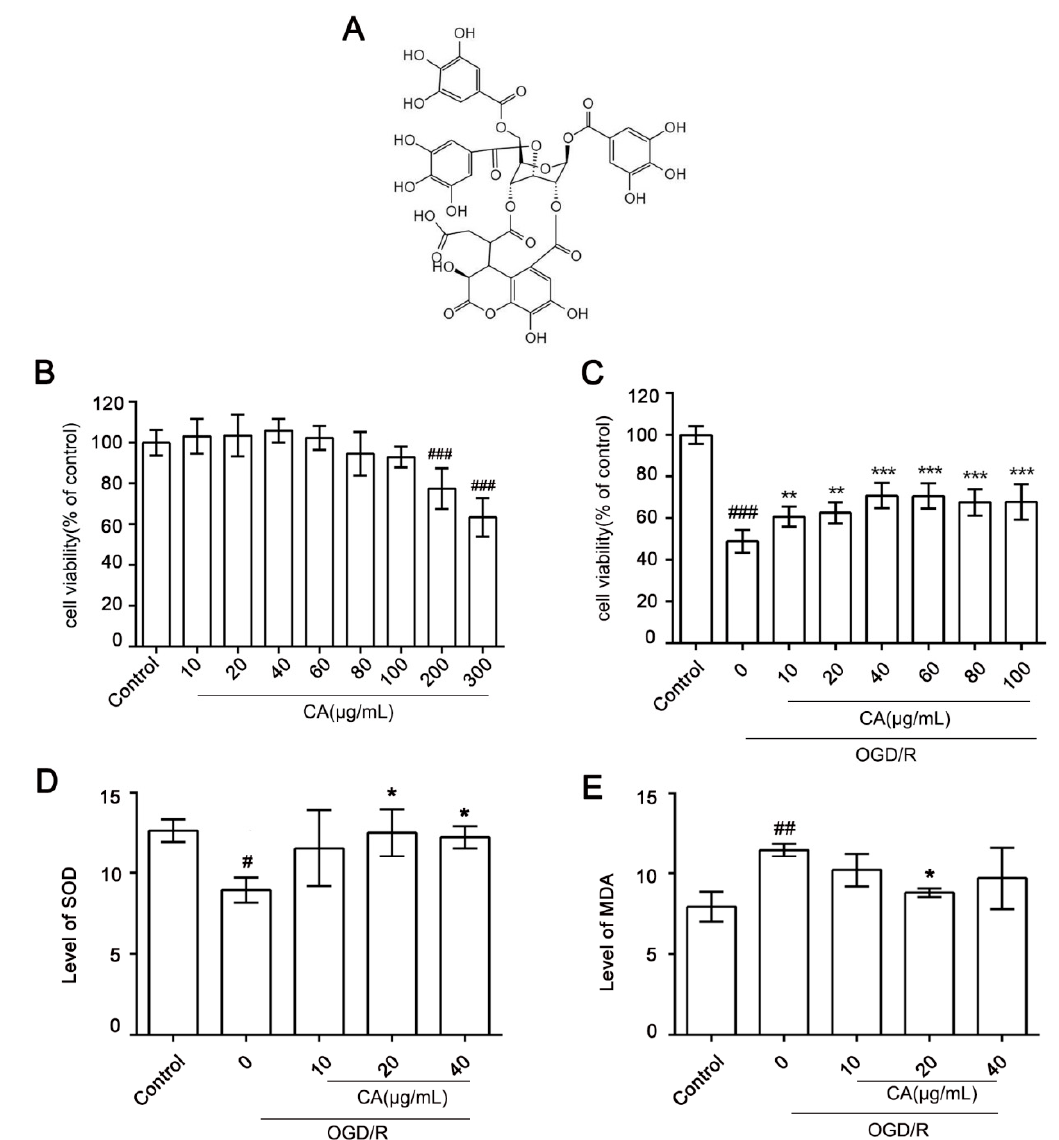
Figure 1. Chebulic acid attenuates OGD/R induced cell death in SH-SY5Y cells. ( A ) Chemical structure of chebulinic acid (CA). ( B ) SH-SY5Y cells were incubated for 24 h with various concentra- tions of CA (10–300 µ g/mL). Cell viability was determined using CCK8 assay; bars represent the percentage of cell viability. ( C ) SH-SY5Y cells were inoculated with different concentrations of CA (10–100 µ g /mL) and exposed to OGD/R. ( D ) T-SOD levels in cells. ( E ) MDA levels in cells. Results are expressed as mean ± SD. # p < 0.05, ## p < 0.01, and ### p < 0.001 compared with the control. * p < 0.05, ** p < 0.01, and *** p < 0.001 versus OGD/R group.